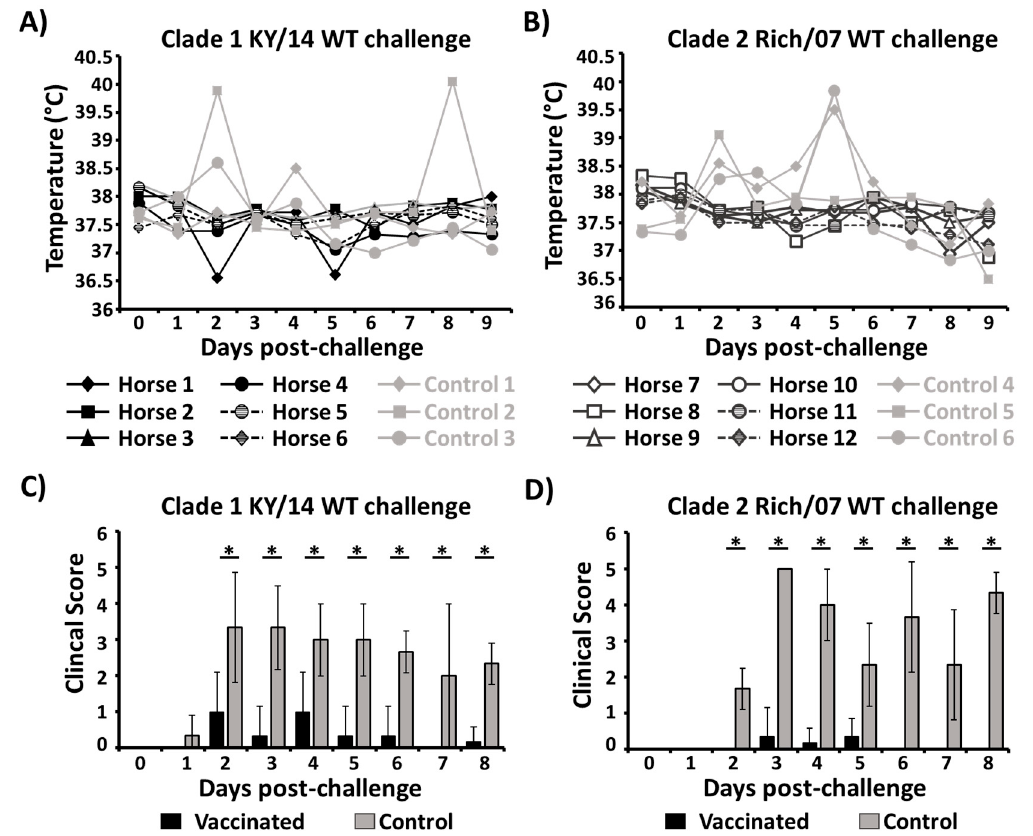
Figure 8. Rectal temperature and clinical scores in vaccinated and control horses after EIV viral challenges: ( A , B ) Rectal temperatures: Rectal temperatures were measured daily over 9 days after challenge of group 1 horses with KY/14 WT ( A ) and group 2 horses with Rich/07 WT ( B ). ( C , D ) Clinical scores: Clinical signs were recorded over 8 days after challenge of group 1 ( C ) and group 2 ( D ) horses. The clinical signs scoring index is found in Table 1 (maximum clinical score of 6). Data represent the means +/ − SDs of the clinical score calculated for vaccinated (black) and control (gray) horses after challenge with KY/14 WT ( C ) and Rich/07 ( D ). * p < 0.005 was considered statistically significant.